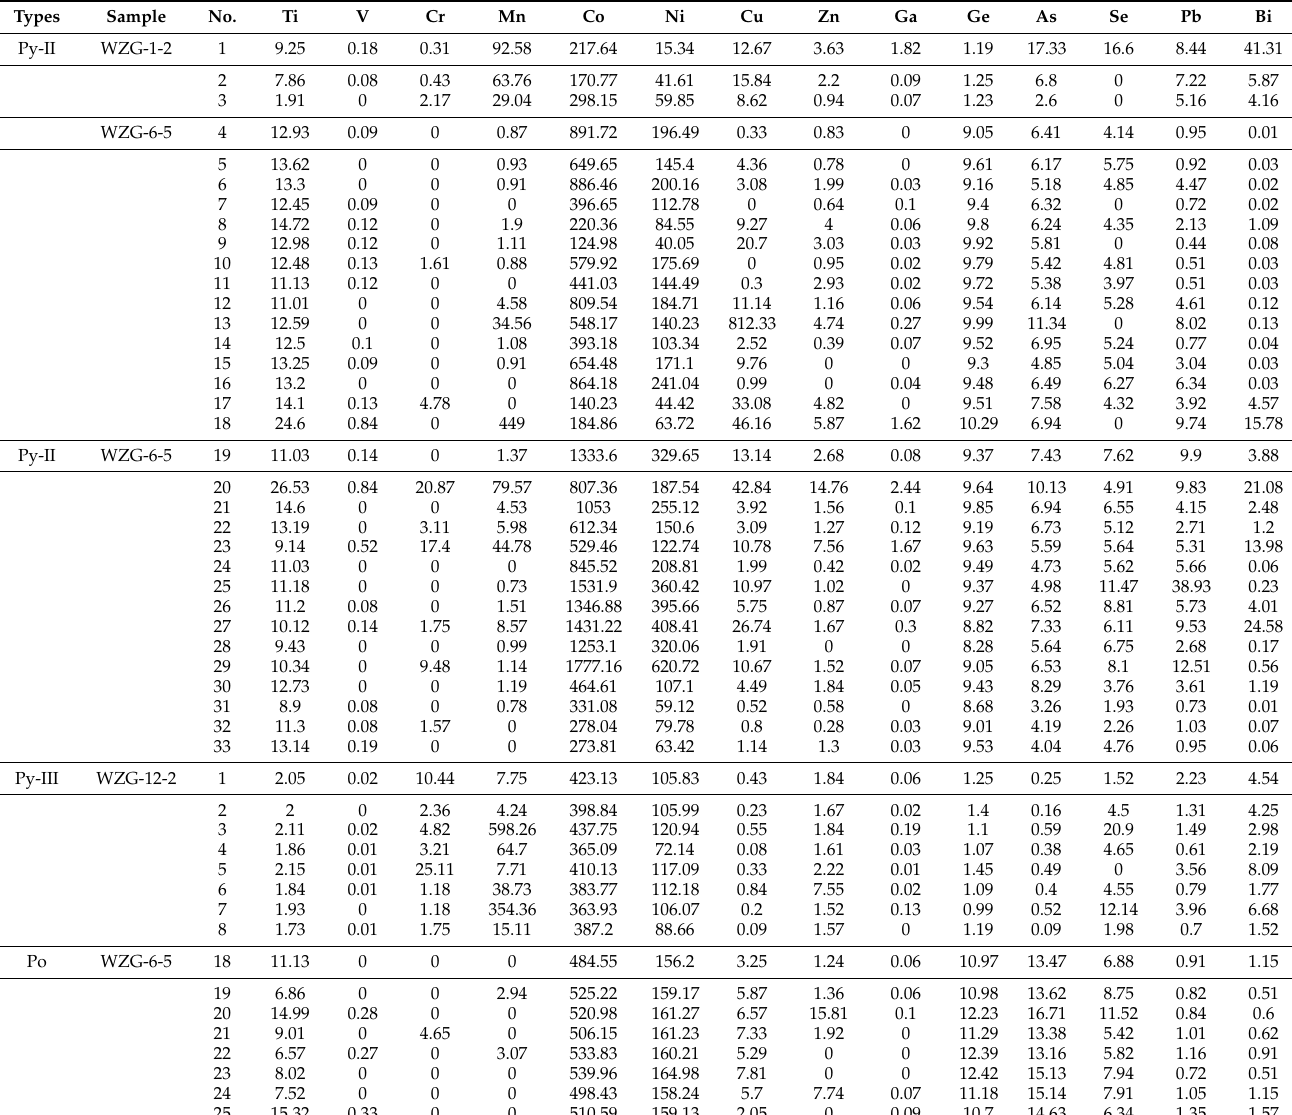
Table 3. LA-ICP-MS results of trace elements (in ppm) of pyrite and pyrrhotite from the Weizigou